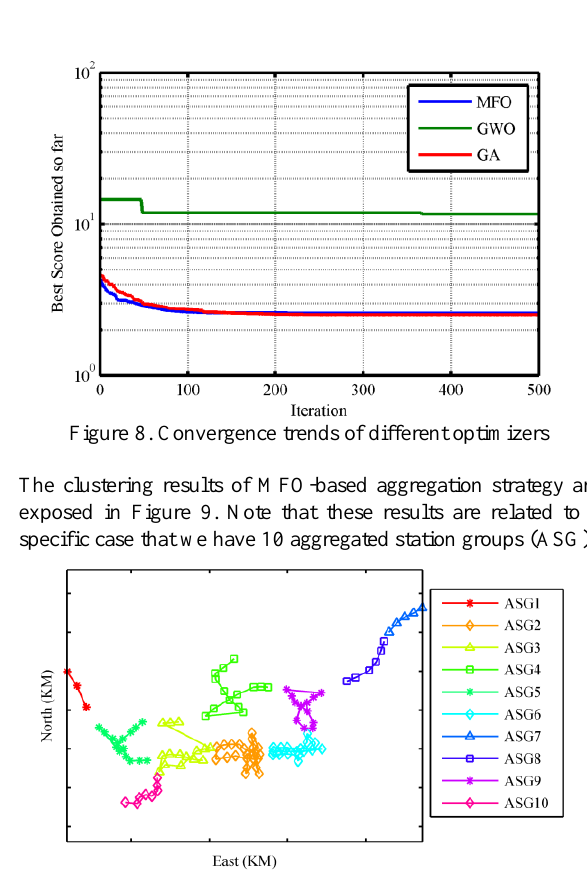
Figure 9. The clustering results for K =10. In Figures 10-13, the results of MFO-based aggregation strategy for k from 1 to 15 are exposed.